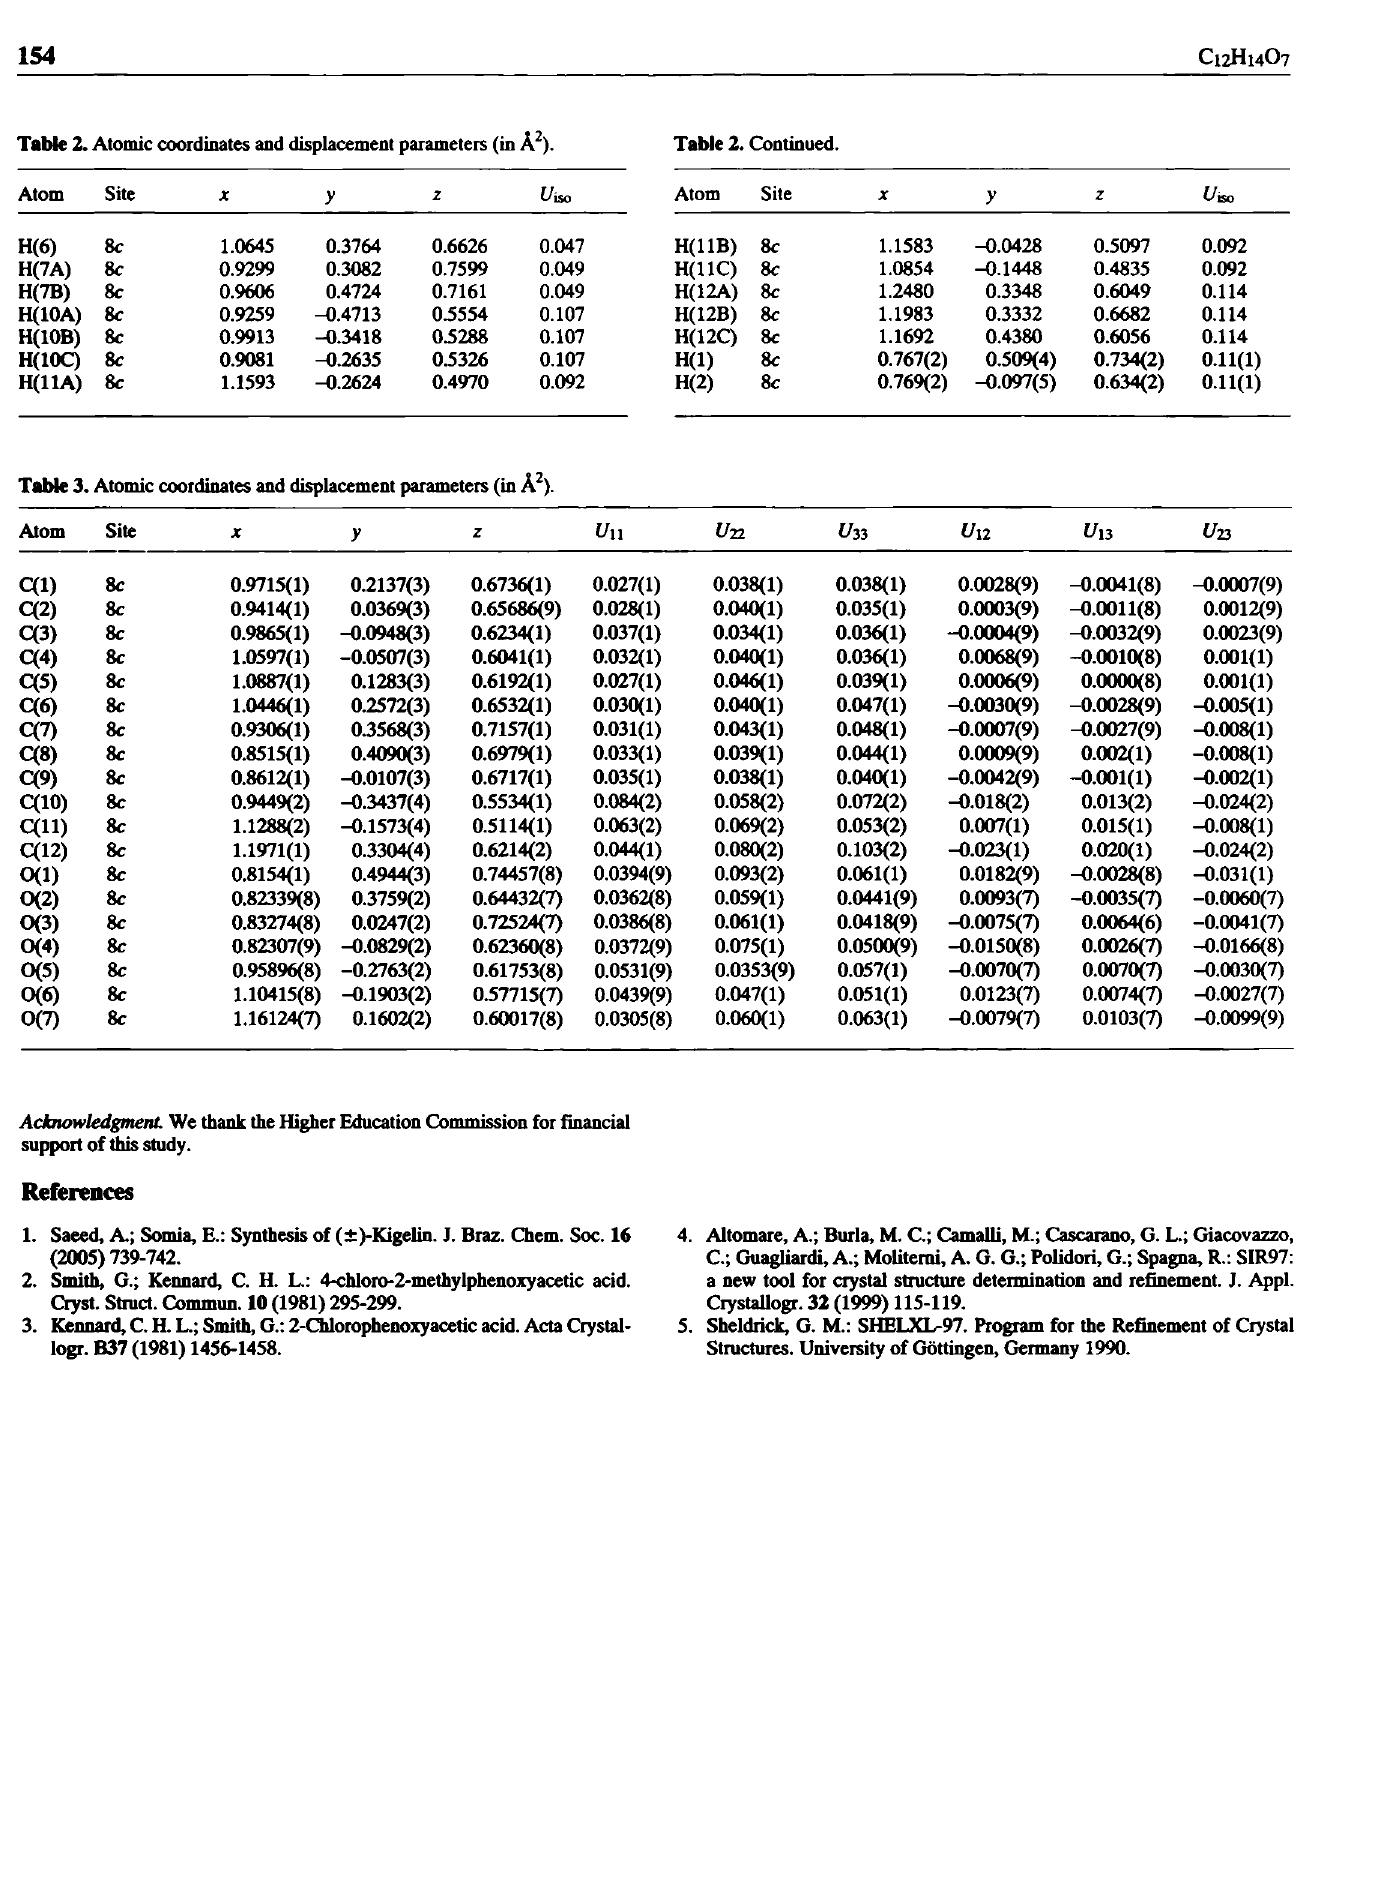
Tabic 2. Atomic coordinates and displacement parameters (in A 2 ).